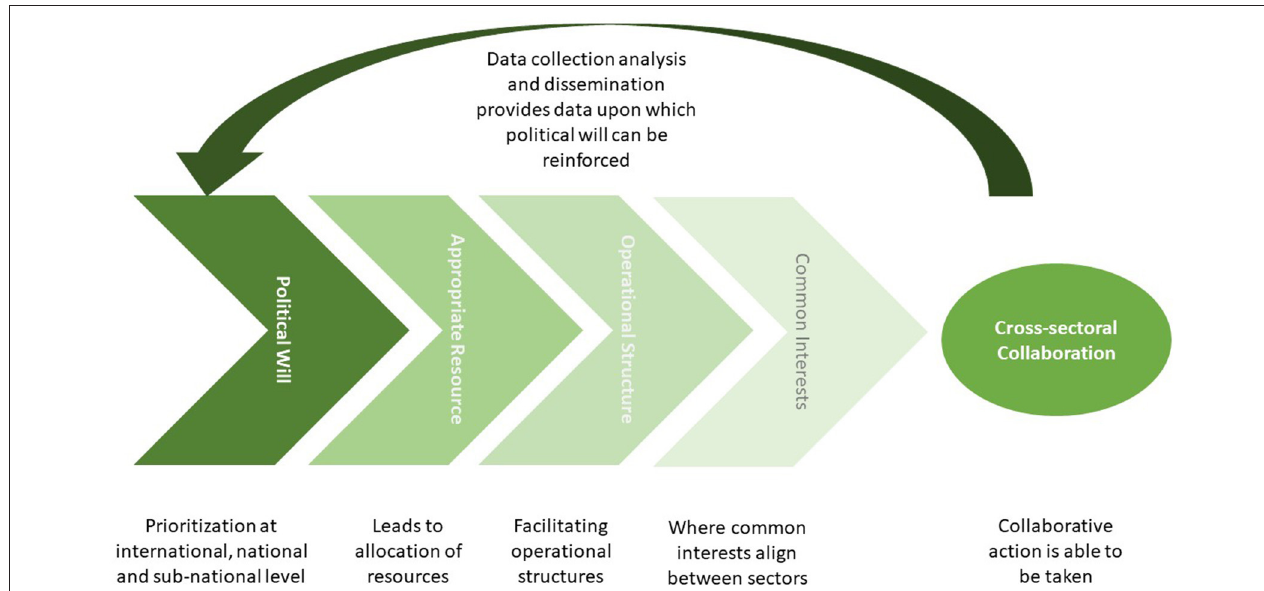
FIGURE 2 | Conceptual framework of how identified themes enable cross-sectoral collaboration within disease surveillance